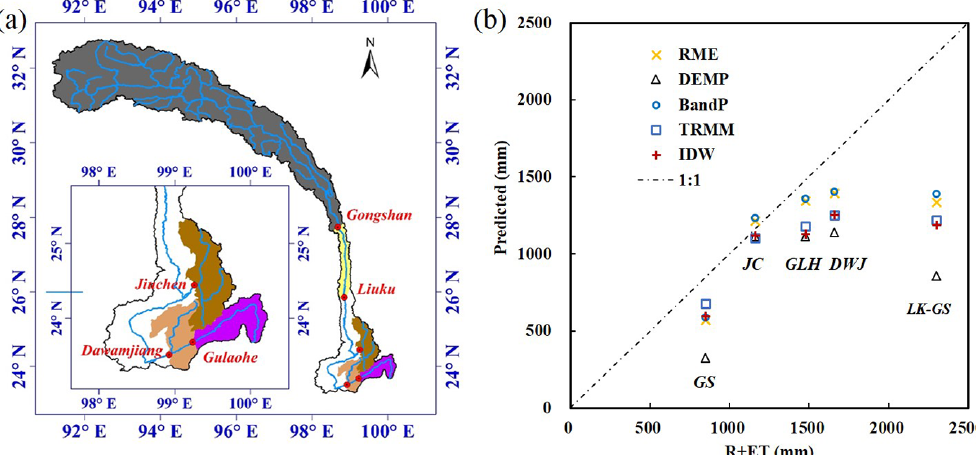
Figure 12. (a) Sub-basins based on hydrological stations. (b) Comparison between precipitations based on basin water balance ( R + ET) and different annual rainfall products: DEMP ( P elevation relationship), BandP ( P –NDVI relationship with consideration elevation band), RME, TRMM, and IDW. GS, JC, GLH, DWJ, and LK-GS are the abbreviations for Gongshan, Jiuchen, Gulaohe, Dawanjing, and Liuku-Gongshan, respectively.